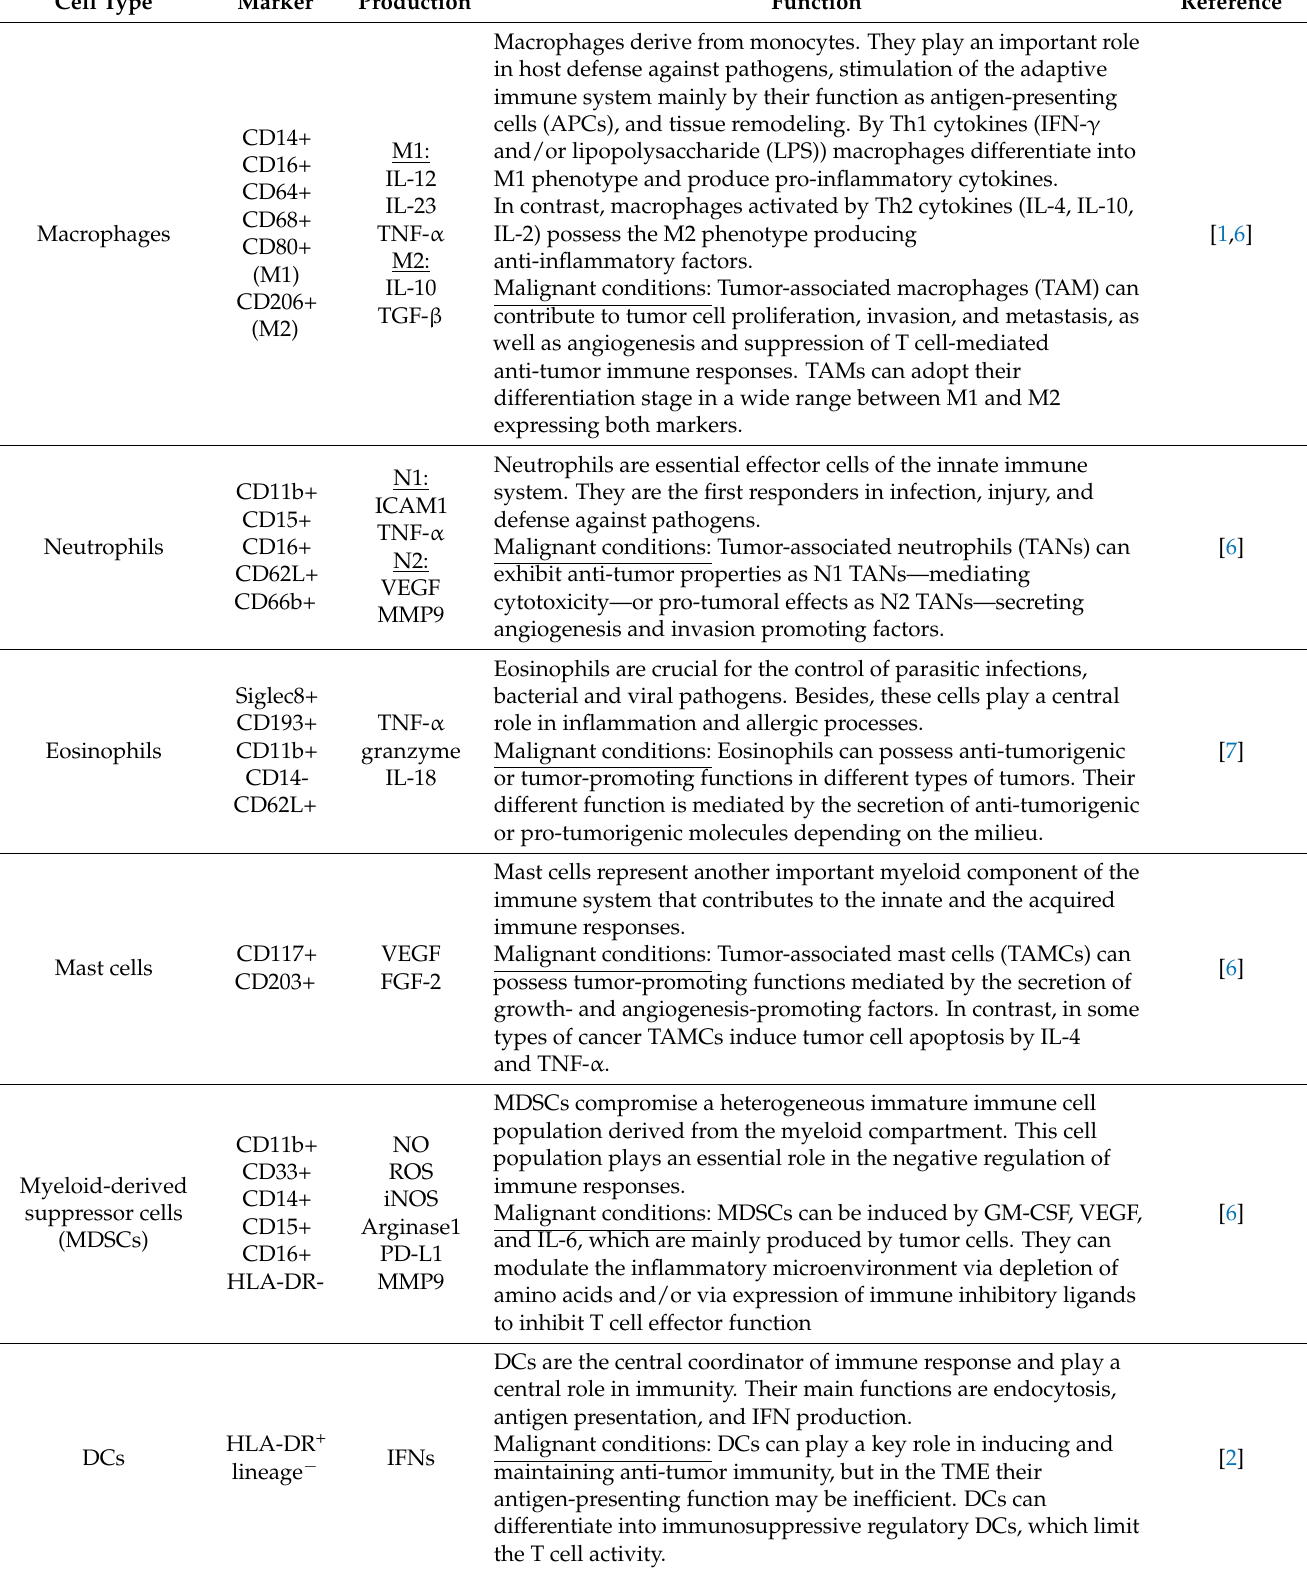
Table 1. Cells of the innate immune system in